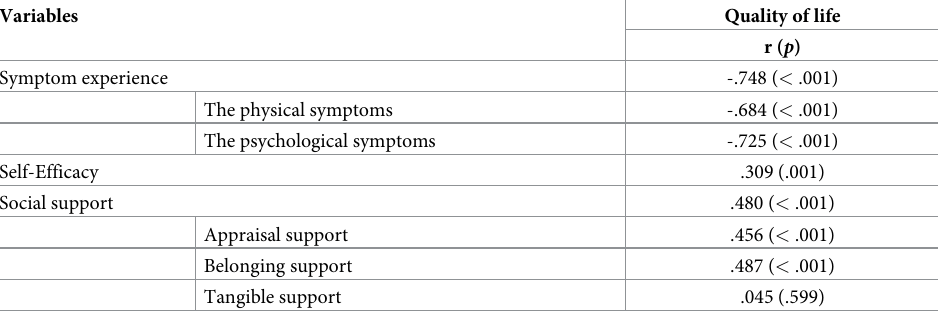
Table 3. Relationships between symptom experience, self-efficacy, social support, and quality of life (N = 140).